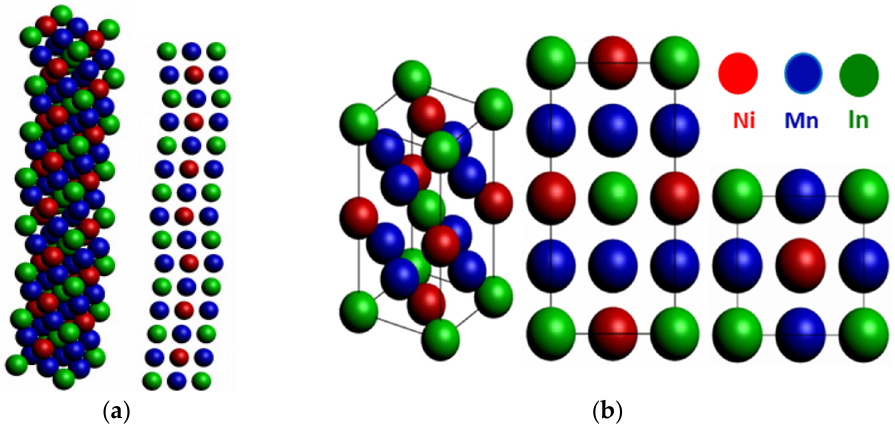
0 ( b ) crystal structures.